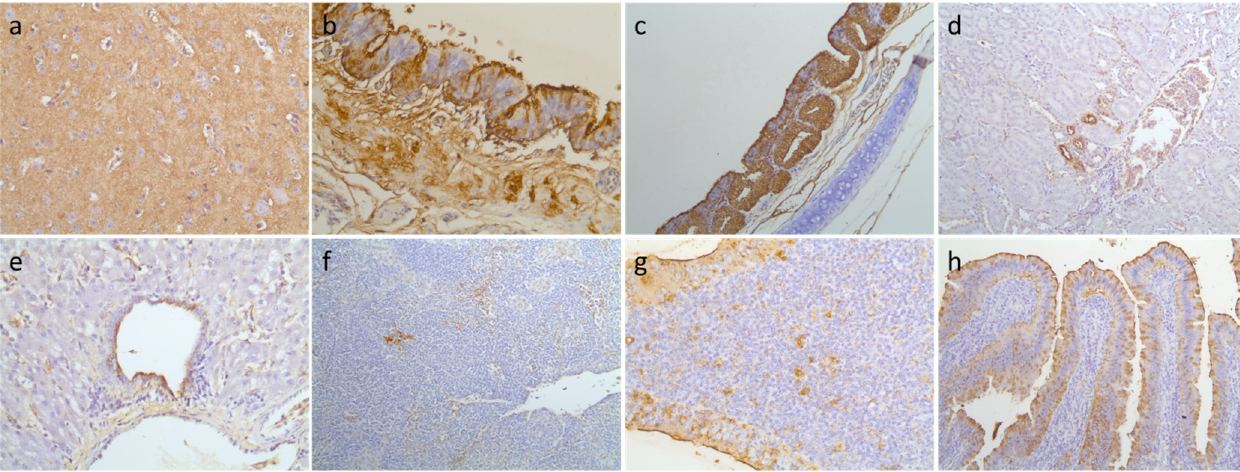
Figure 4. Immunohistochemistry of organs from domestic pigeons. Influenza-specific signals were detected by diaminobenzidine (brown precipitate) in the ( a ) brain (400×), ( b ) lung (400×), ( c ) trachea (200×), ( d ) kidney (200×), ( e ) liver (400×), ( f ) spleen (200×), ( g ) cecal tonsil (400×), and ( h ) intestine (200×) of domestic pigeons infected with H5N6 genotype C1.